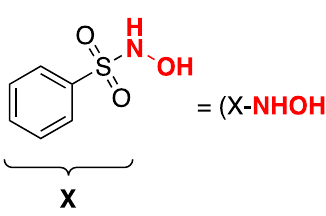
Figure 1. Piloty’s acid (PI) molecular structure.